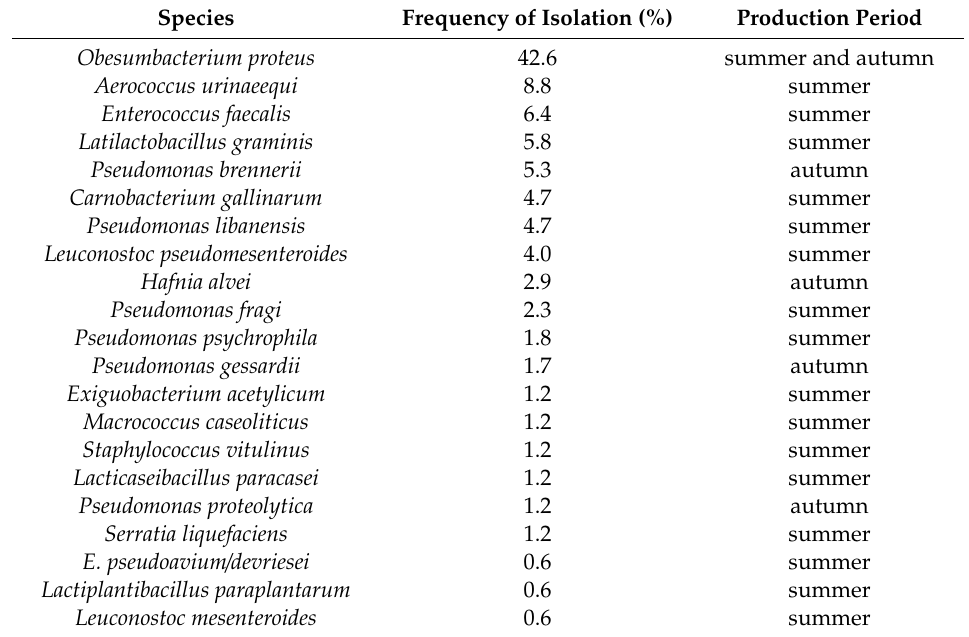
Table 2. Prevalence of bacterial species isolated from spoiled cheeses and time of production. Species Frequency of Isolation